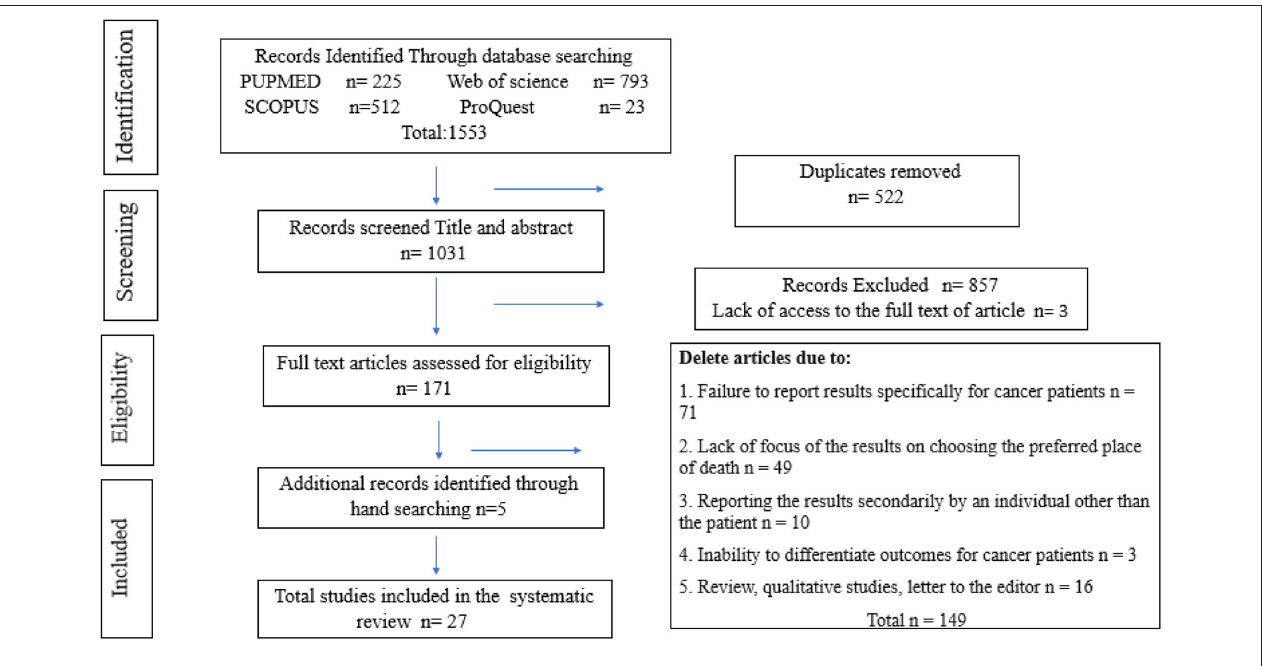
FIGURE 1 | PRISMA